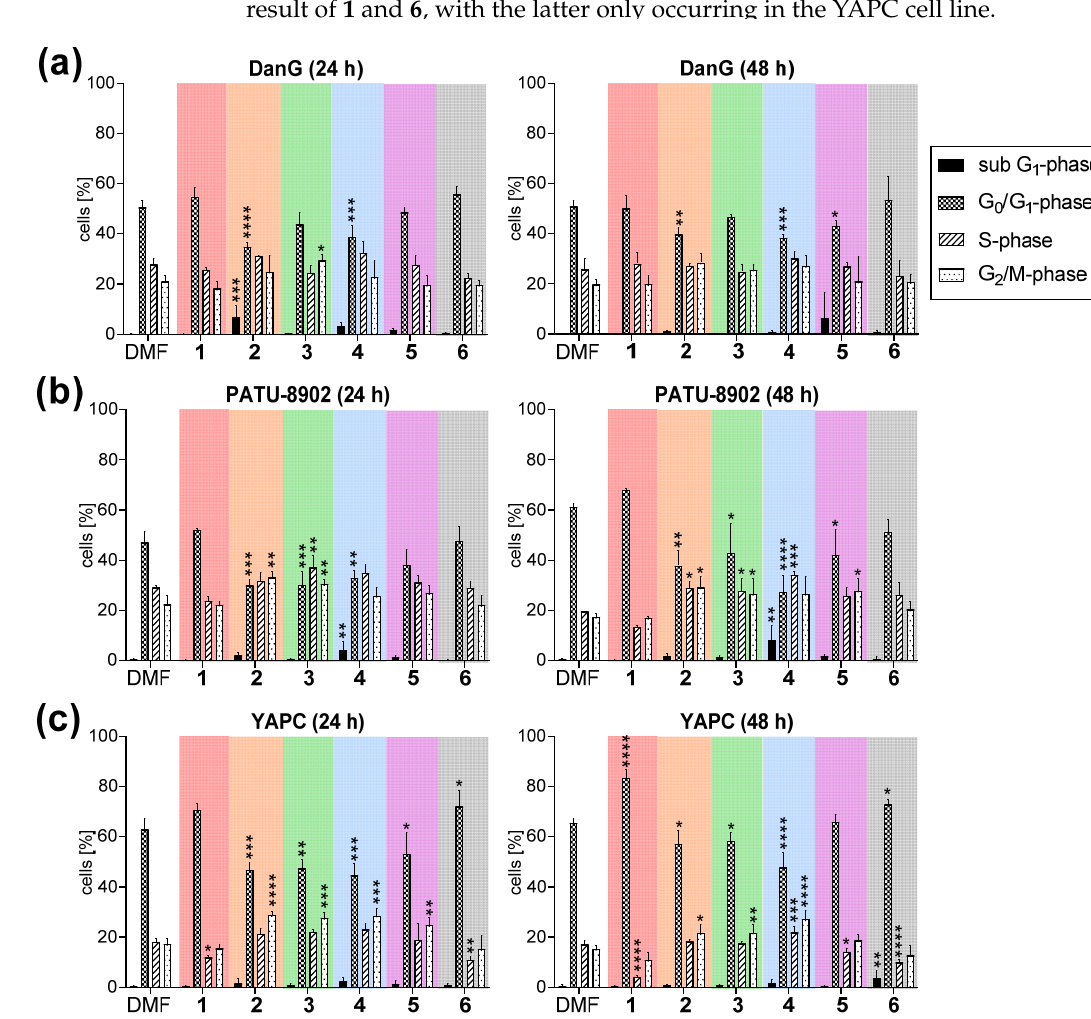
Figure 18. Distribution of cell cycle phases in HAP-1 ( a ), HAP-1.KO.GPx1 ( b ), A2780 ( c ), and Siso ( d ) after a treatment for 24 (left) and 48 h (right) with the respective pentathiepin (IC 90 ) or the solvent DMF as negative control. Representative histograms are provided in Figure S46. The fractions of cells in either sub G 1 -, G 0 /G 1 -, S-, or G 2 /M-phase are displayed as mean and SD. Asterisks indicate differences between the solvent control and the treatment condition. Statistical analysis was performed in Prism 7 by one-way ANOVA and Dunnett’s multiple comparisons post hoc test. n = 3 independent